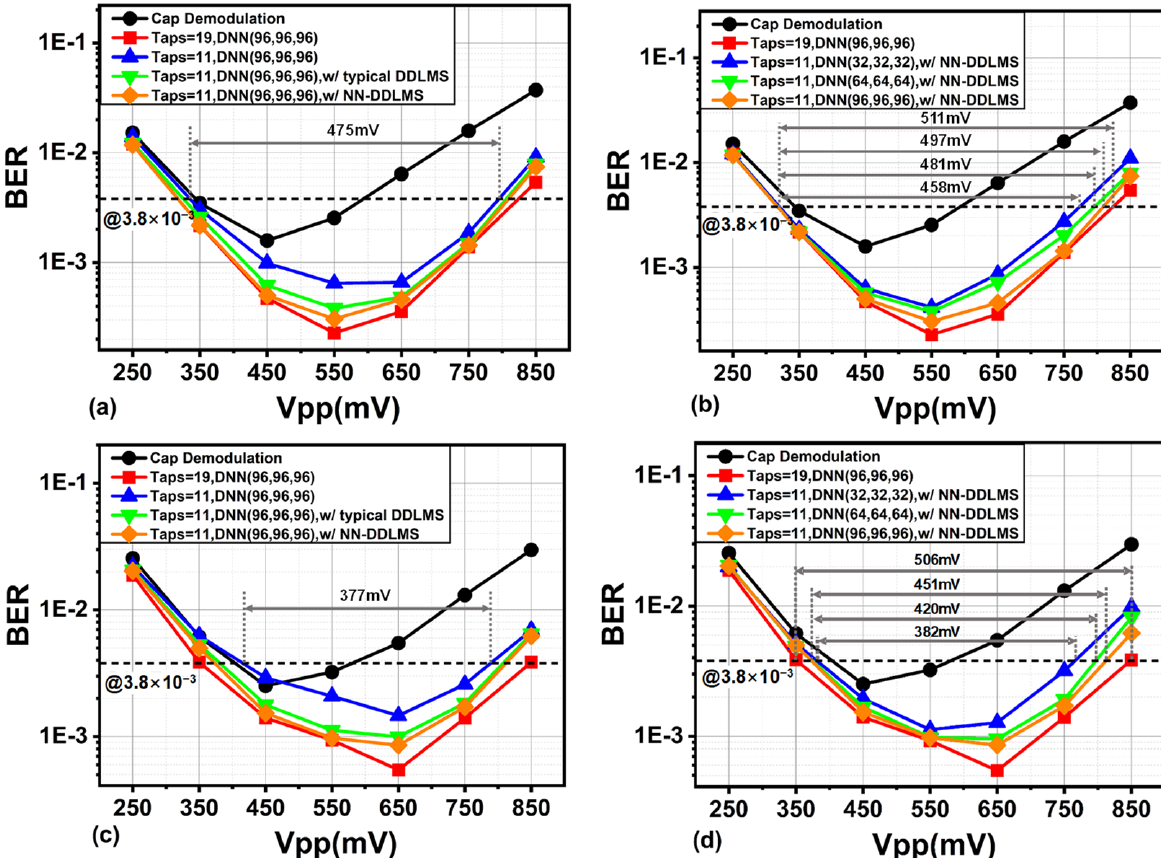
Figure 11. BER of different decoders versus different signal Vpp for ( a ) 64APSK; ( b ) 64APSK; ( c ) 64QAM; ( d ) 64QAM.